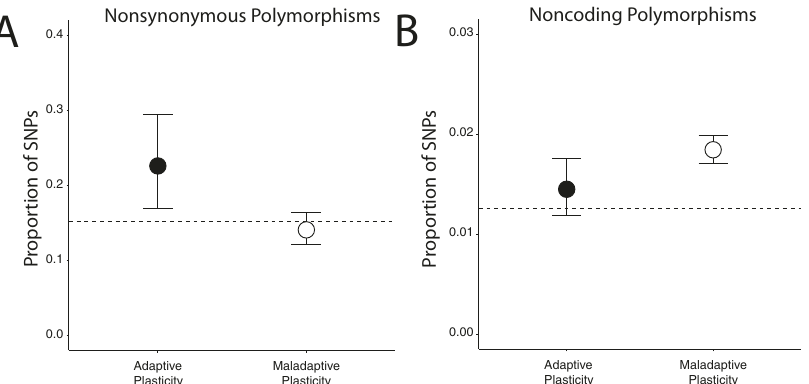
Fig. 8 Evidence for different targets of selection on adaptive and maladaptive plasticity. A Single-nucleotide polymorphisms (SNPs)-associated adaptive plasticity display a signi fi cant enrichment of nonsynonymous polymorphisms, whereas those associated with maladaptive plasticity do not. B Single- nucleotide polymorphisms-associated maladaptive plasticity display a signi fi cant enrichment of noncoding polymorphisms), whereas those associated with adaptive plasticity do not. Dots and bars represent the proportion of SNPs among genes associated with adaptive (black) and maladaptive (white) plasticity, and 95% con fi dence intervals, respectively. Horizontal dotted lines represent expected proportions estimated from transcriptome-wide background (SNPs among genes unassociated with heat tolerance). All 130 animals for which we had sequence data were used in this